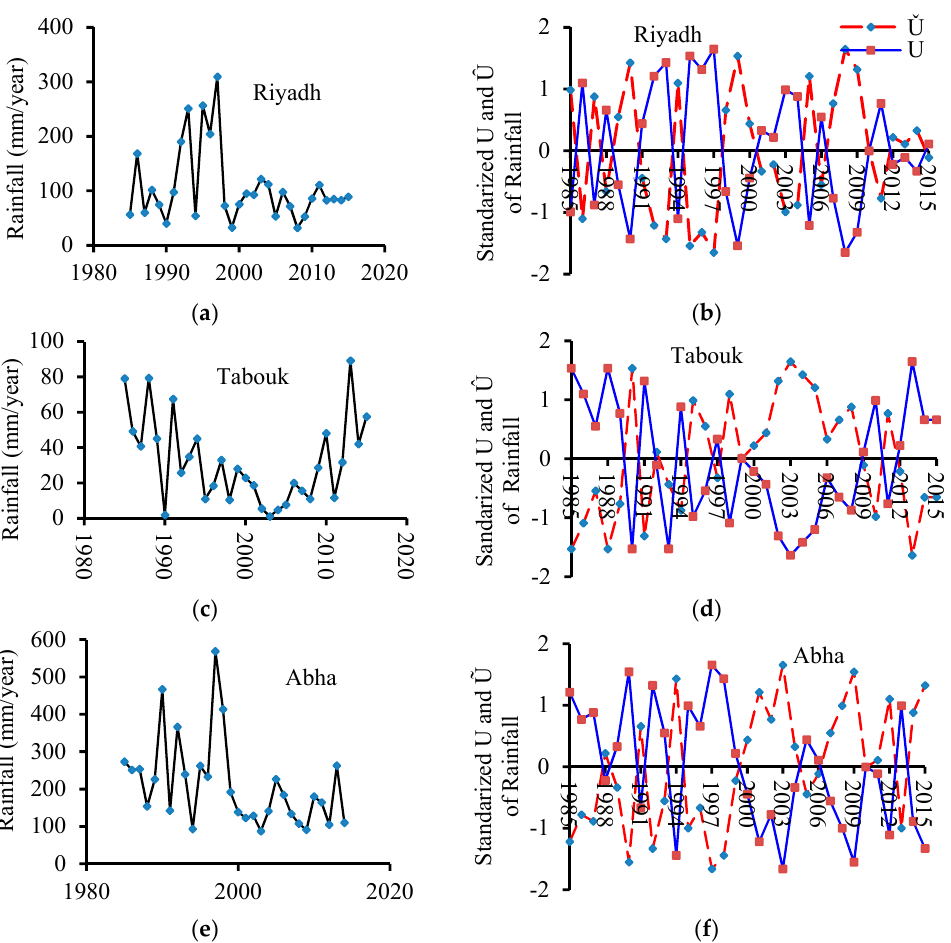
Figure 5. Linear trends (left) and the sequential version of the Mann–Kendall trends (right) of the mean annual rainfall for the central ( a , b ), north ( c , d ) and southwest ( e , f ) regions (1985–2013). U( t ) and Û( t ) are the sequential M–K statistics, computed through forward and backward starting of the time series data.